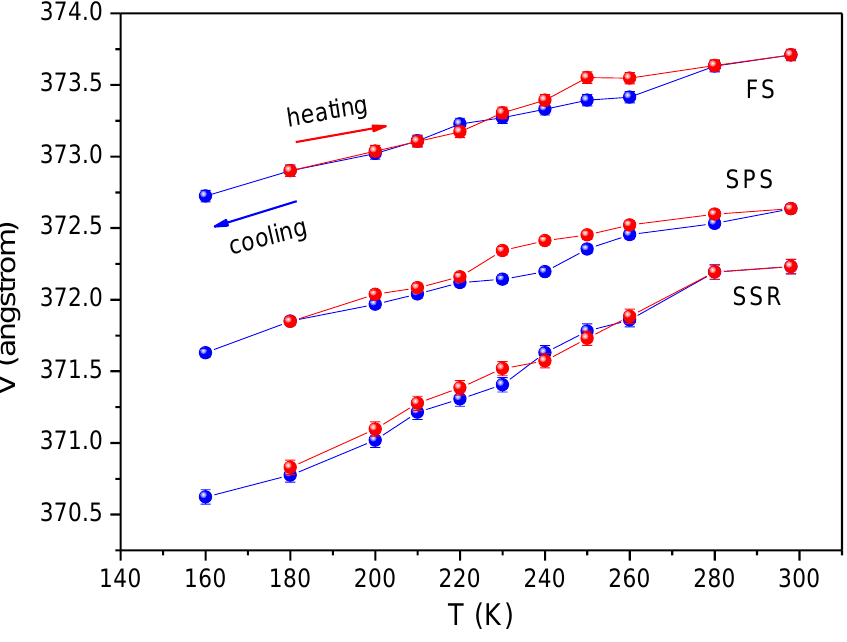
Figure 5. Cell volume of BiFeO 3 as a function of temperature for all the studied samples.